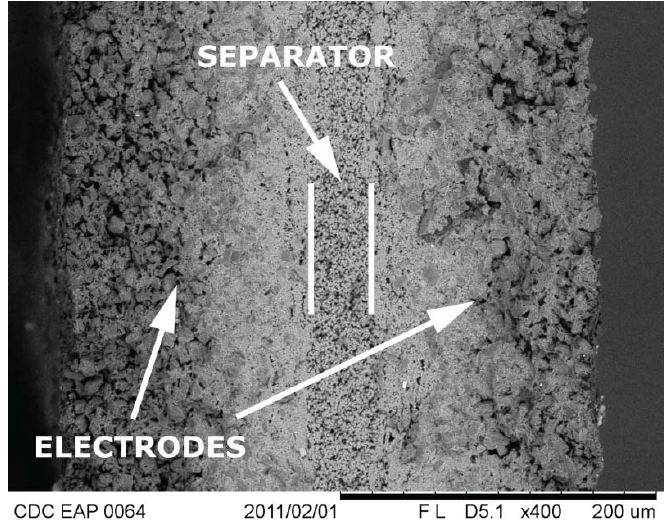
Figure 2. SEM (at 5 kV) image of the cross-section of the CPC